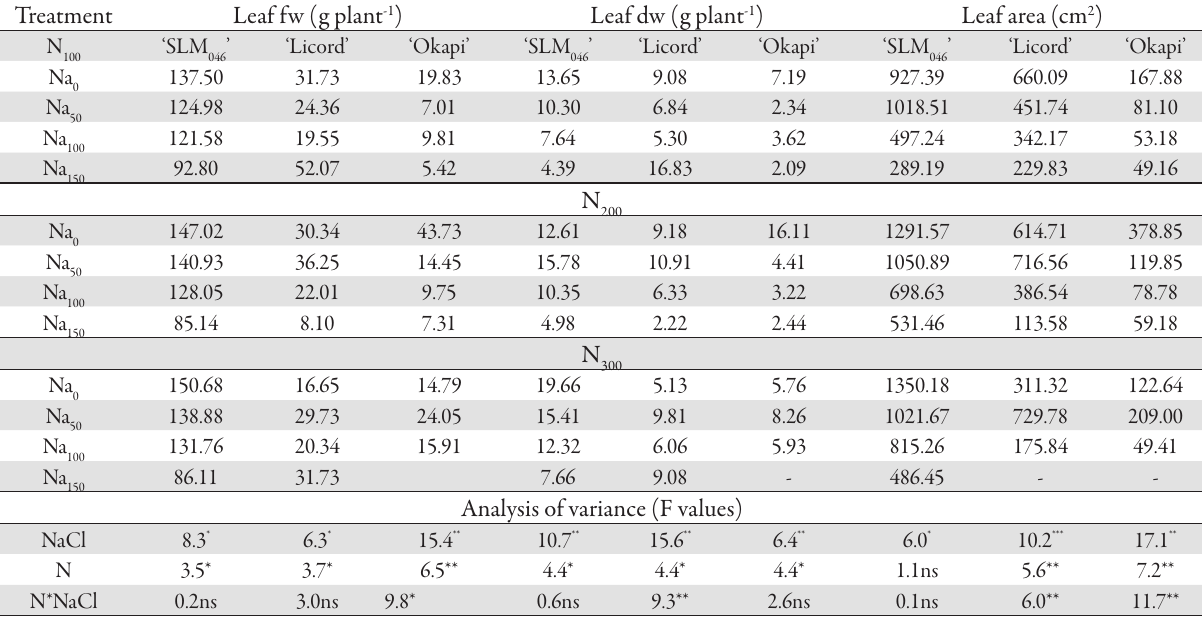
Tab. 1. The effect of salinity and N levels on the vegetative characteristics of canola cultivars Treatment